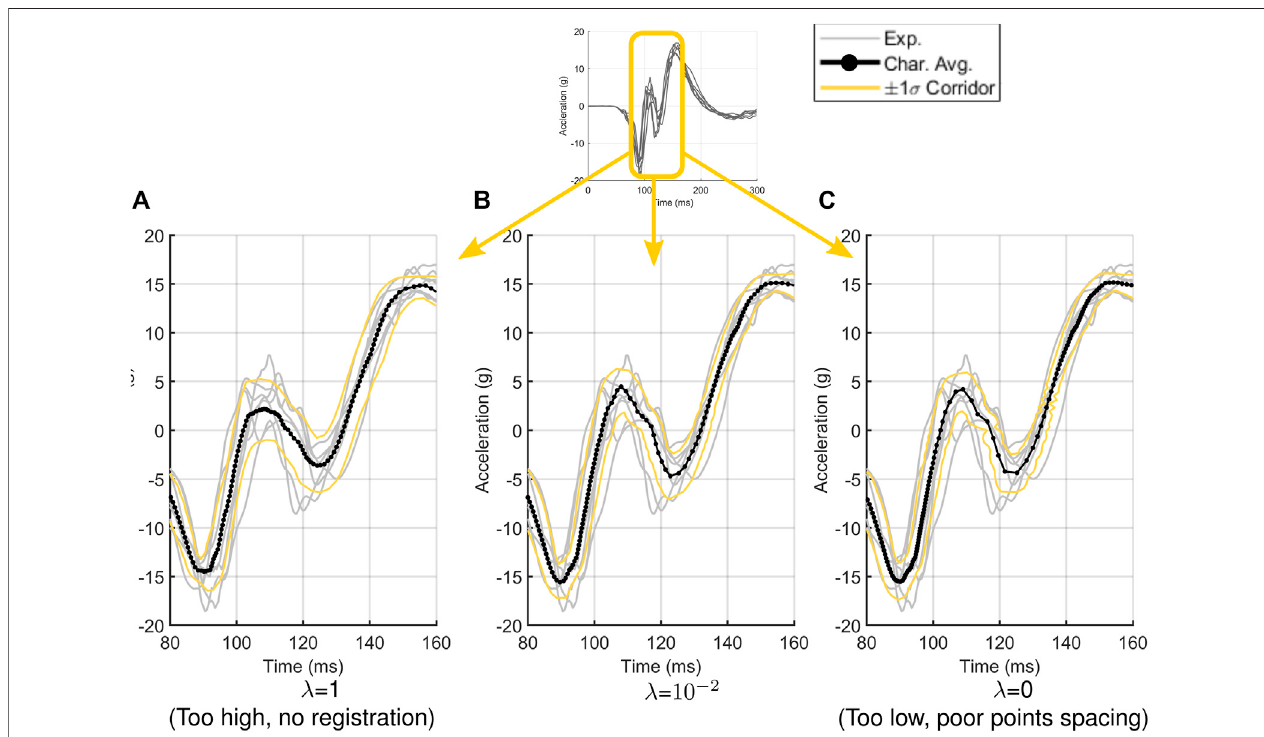
FIGURE 14 | The effect of penalty factor λ on the characteristic average and response corridors for head acceleration in the z -direction. If the penalty factor is high (A) ,signalregistrationisnotperformed.Ifthepenaltyfactorislow (C) ,signalregistrationcanskewpointstowardscertainfeatures,producingareasofpoordiscretization and signal resolution. Appropriate penalty factor selection (B) produces a curve that captures signal features without signi fi cant changes in point density.